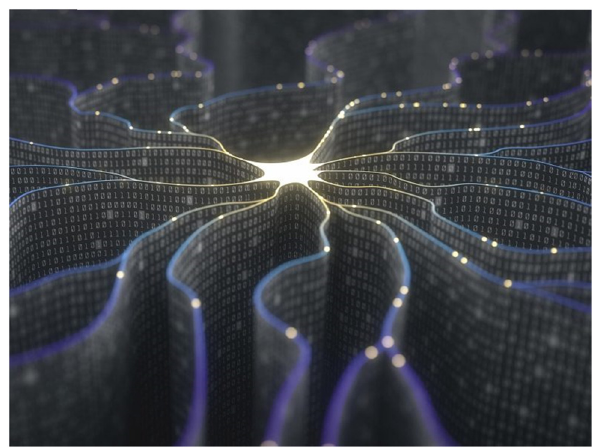
Figure 1: Essential components of a neuron shown in stylized form [ 2 ]